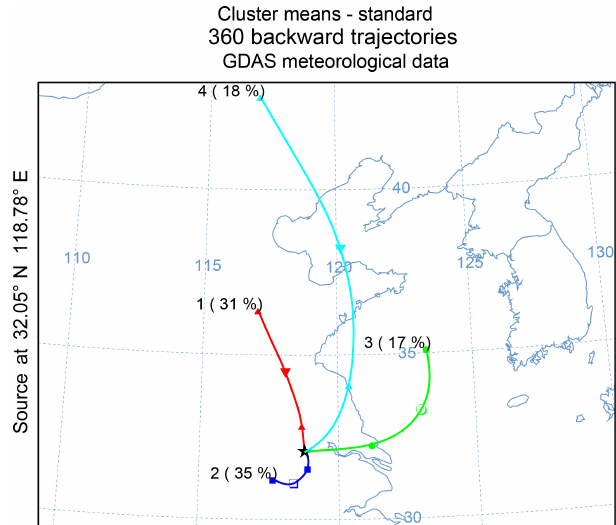
Figure 13. Clusters of 96h back trajectories arriving at the Gulou site at 100m in the winter of